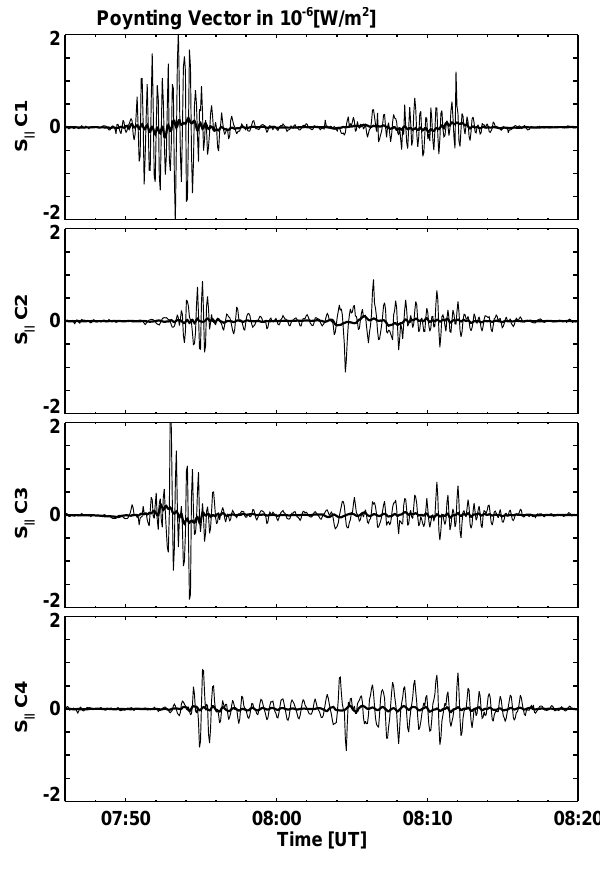
Fig. 4. Field parallel components of the Poynting vector S p ob- served by Cluster spacecraft. The thick line represents the time av- eraged energy flux.